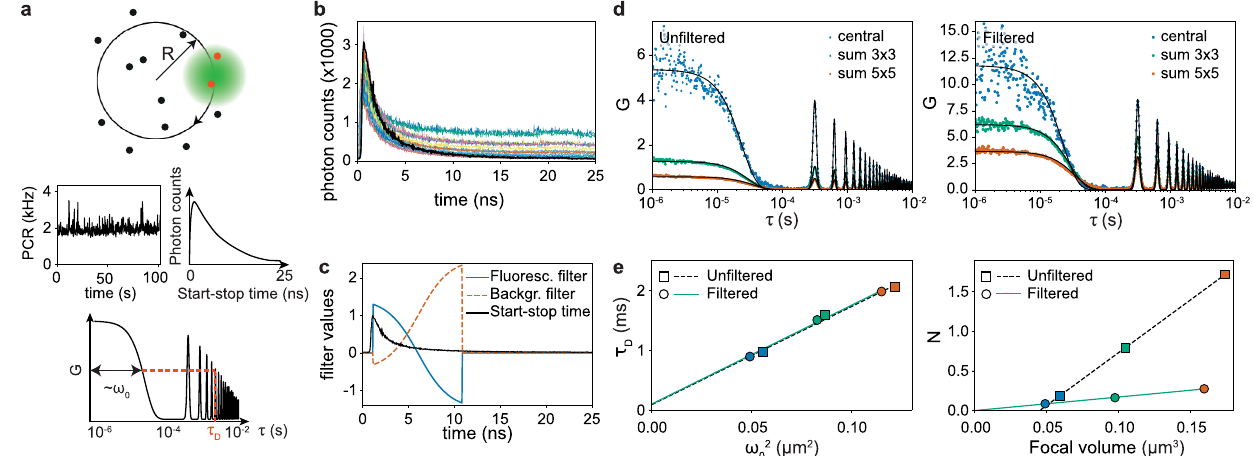
Fig. 5 | BrightEyes-TTM for circular scanning FLFS on freely diffusing fl uor- escentbeads.a SchematicrepresentationoftheconceptofcircularscanningFLFS. A pulsed laser beam is scanned in circles of radius R (top panel) while both the absolute arrival times (center-left panel) and the start – stop times (center-right panel) are registered. The autocorrelation function of the intensity trace is calcu- lated, from which the size of the focal spot ω 0 and the diffusion time τ D can be simultaneouslyextracted. b Start – stoptimehistogramsforthedifferentpixels,bin width48ps,totalmeasurementtime226s,centralpixelinblack. c Exemplary fi